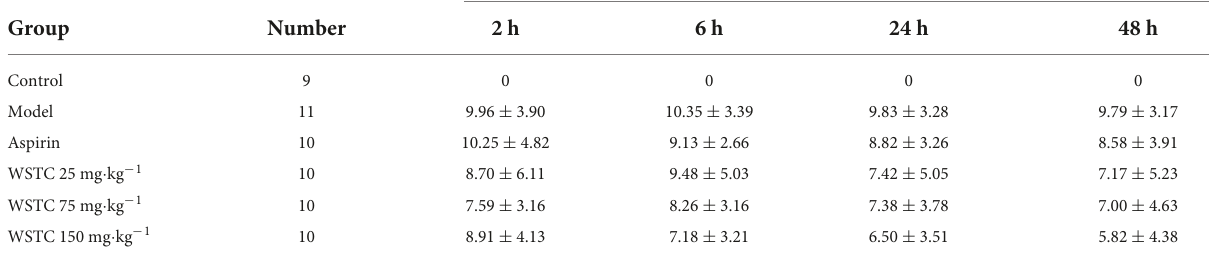
TABLE 1 κ -carrageenan injection induced the black rat tail length at different time points with different treatment/cm ( ¯ x ± s ). Time points after κ -carrageenan